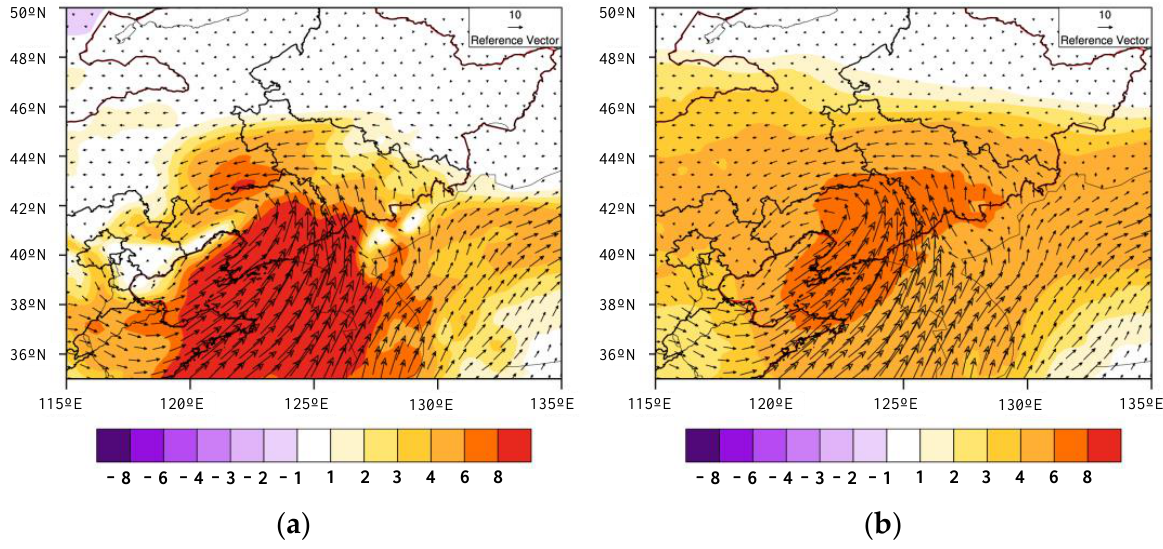
Figure 8. ( a ) 850 hPa wind field (arrow) and standardized abnormality of water vapor flux (color) at 20:00 on 18 November, ( b ) 850 hPa wind field(arrow) and standardized abnormality value of whole layer precipitable water(coloring) at 20:00 on 18 November.